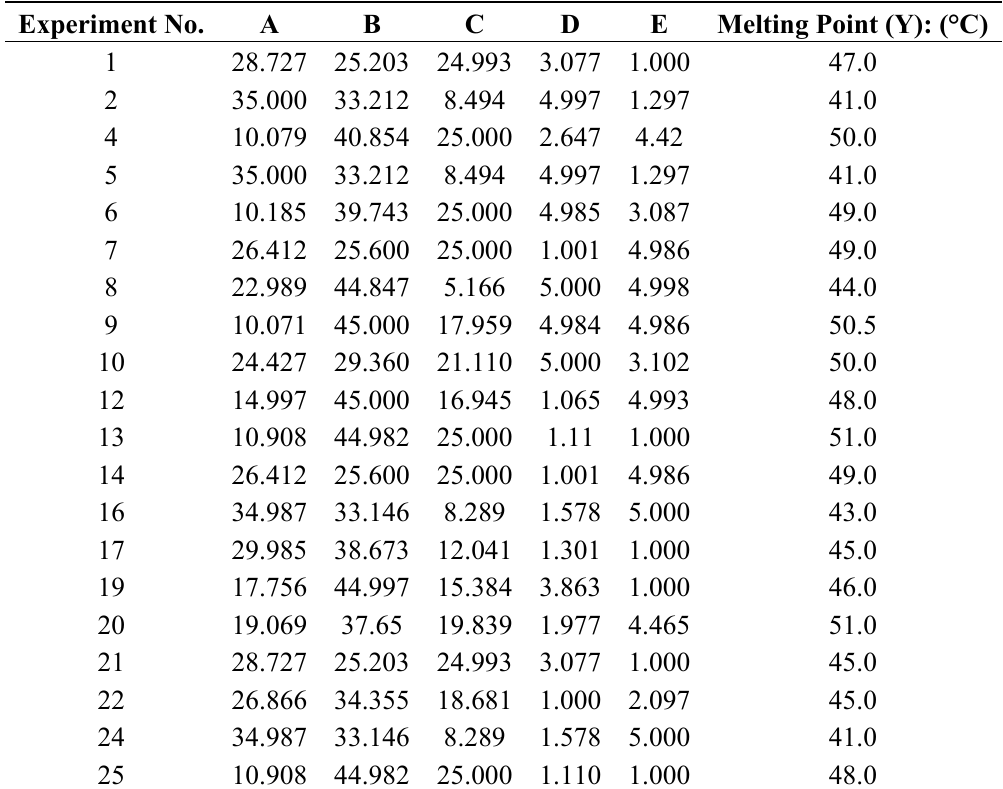
Table 1. Experimental data and response (melting point) obtained from the mixture design. Letter code: pitaya seed oil ( A ), virgin coconut oil ( B ), beeswax ( C ), candelilla wax ( D ) carnauba wax ( E ), melting point ( Y